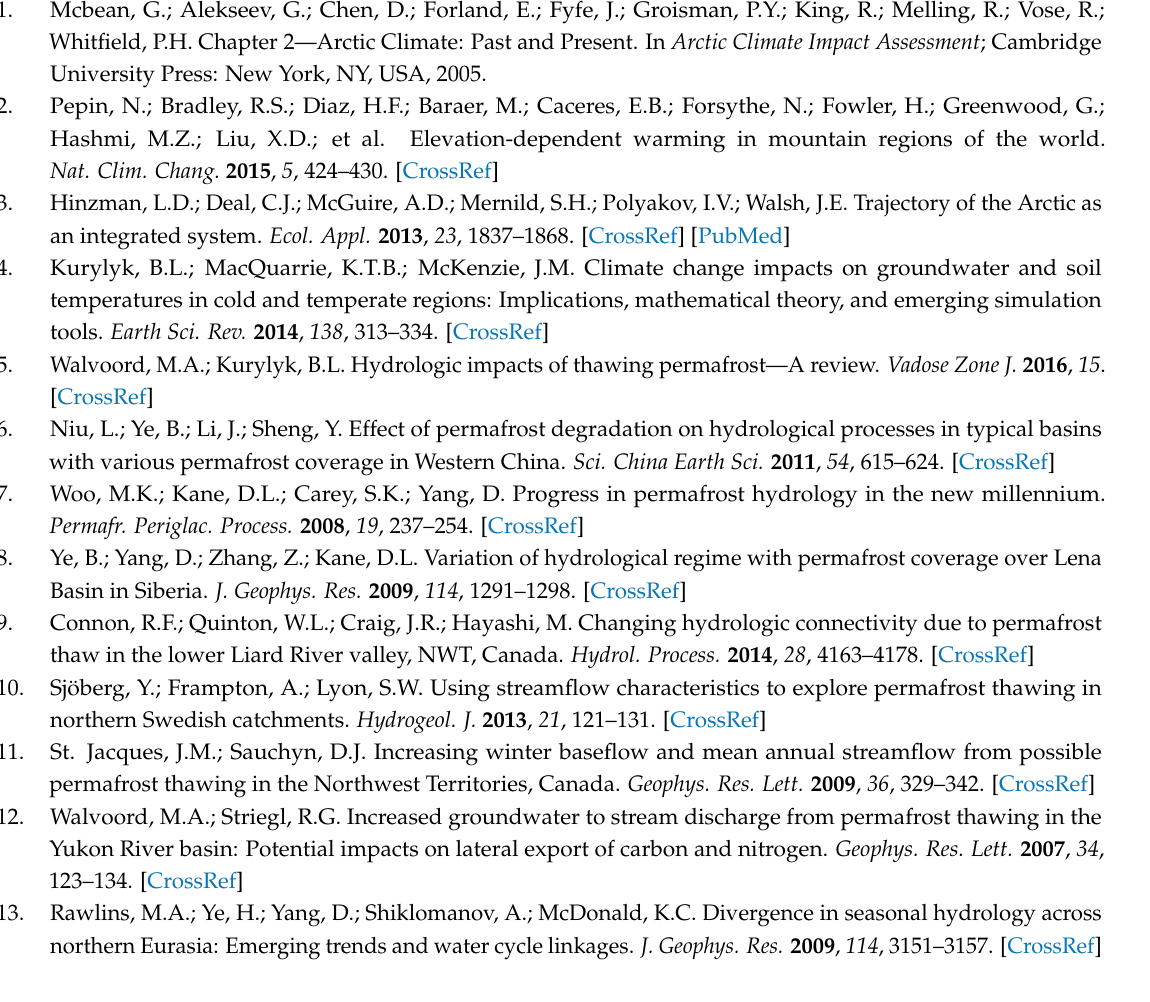
Figure S1: Location of the 36 meteorological stations in and around the source regions; Figure S2: Distribution of multi-year average summer precipitation (1960–2015) in the source regions; Figure S3: Correlation between summer precipitation (July–September) and the following winter discharge (December–February) for the period before 1985 (blue) and after 1985 (red); Figure S4: Change rate of summer precipitation (July–September) for all 10 catchments within the source